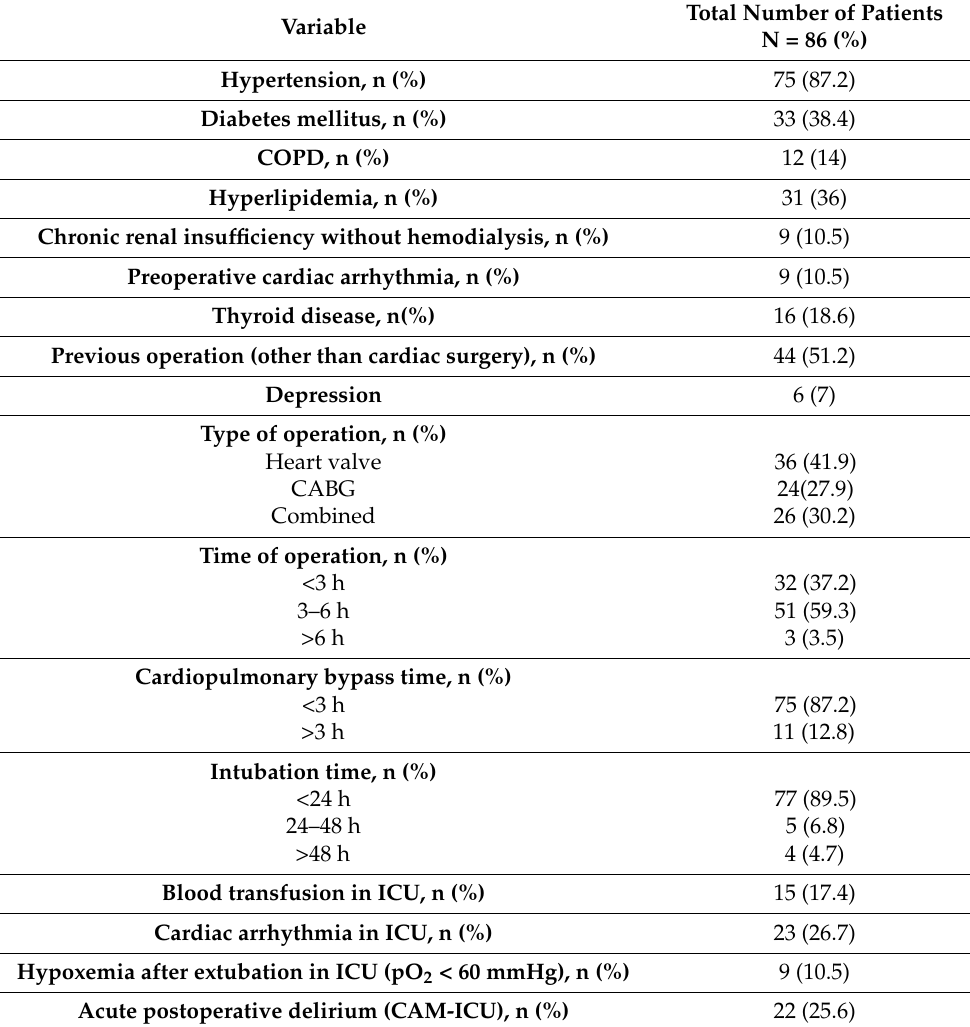
Table 2. Preoperative and intraoperative details. Number = N or n; chronic obstructive pulmonary disease = COPD; coronary artery bypass grafting = CABG; intensive care unit = ICU; confusion assessment methods-intensive care unit =